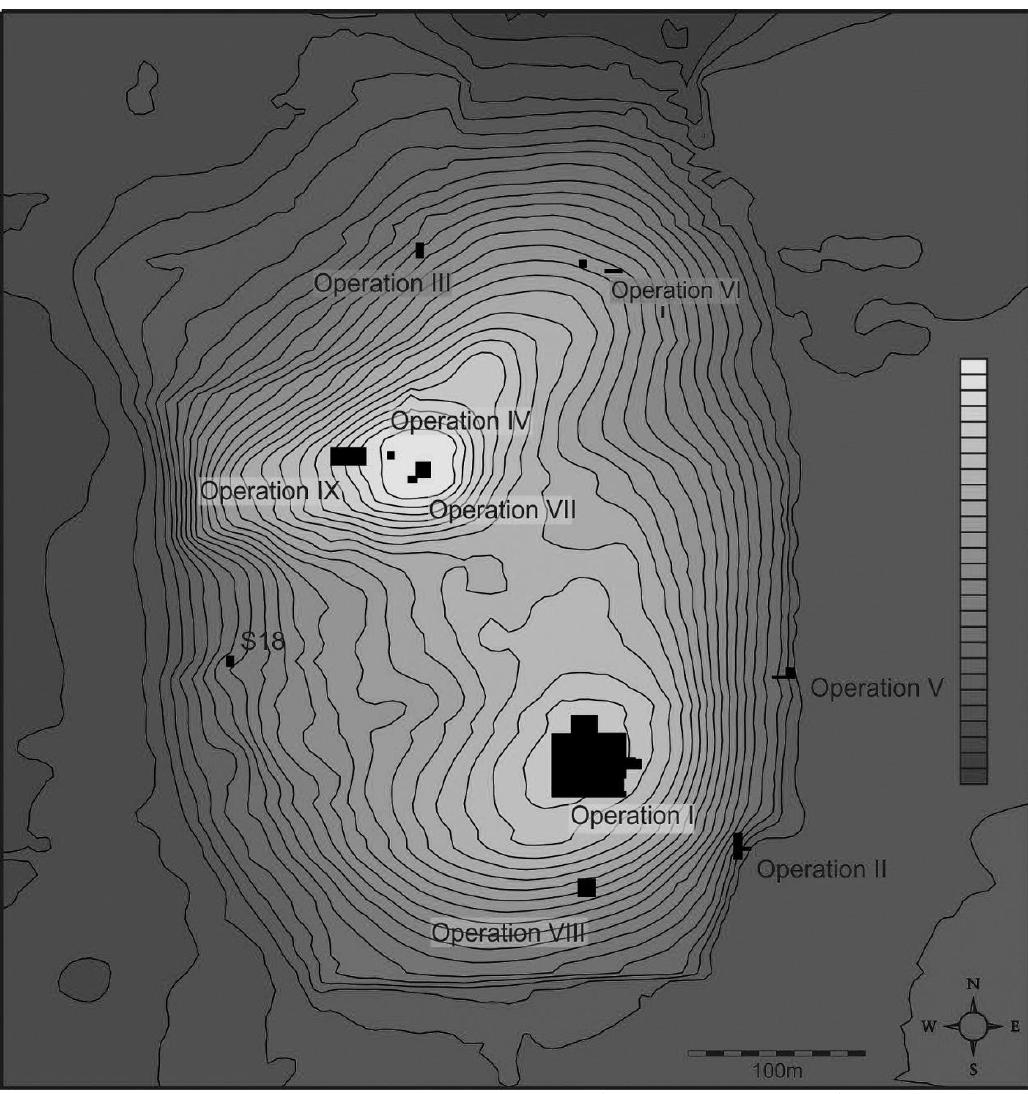
Figure 2. Contour plan of Domuztepe, showing excavated areas (source Stuart